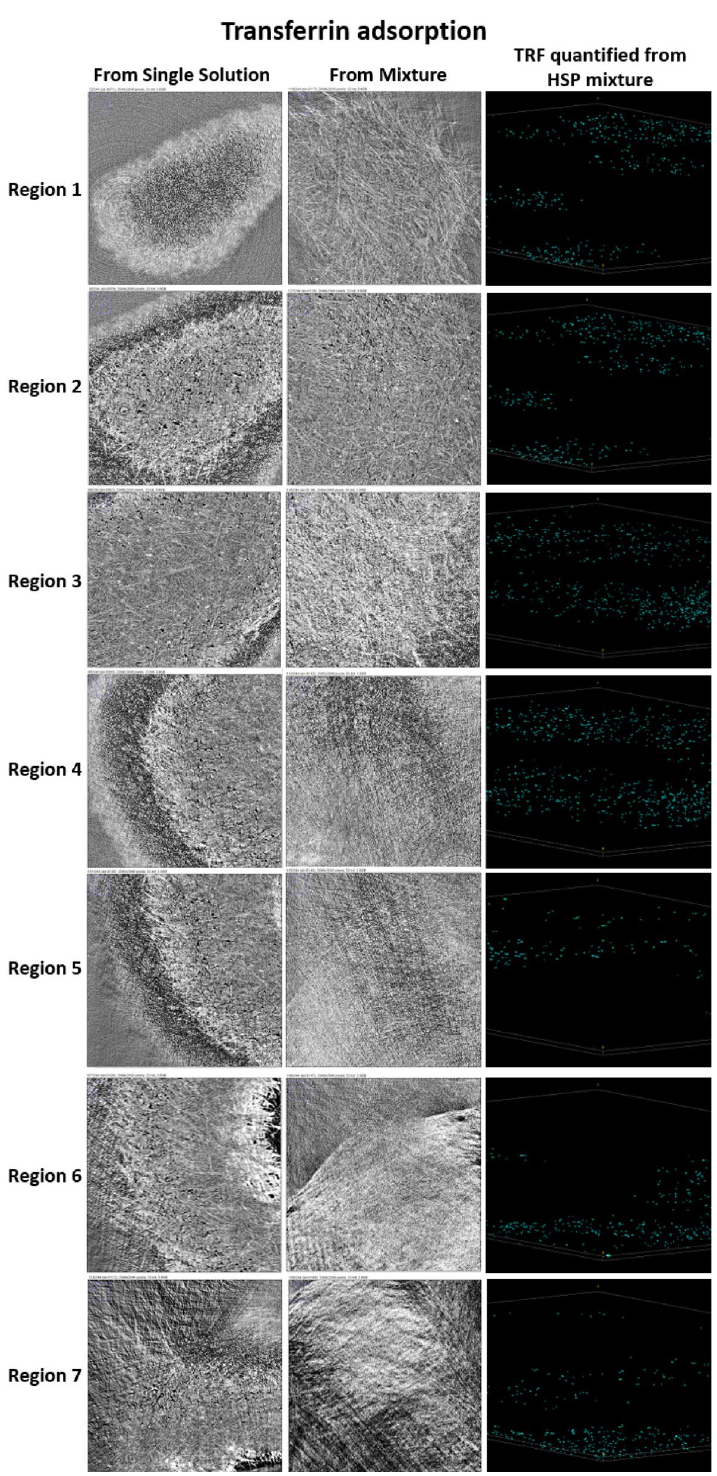
Figure8. Converted radiographs of PES membrane with adsorbed FB from its single solution and HSP, and visualization of the FB distribution across the membrane